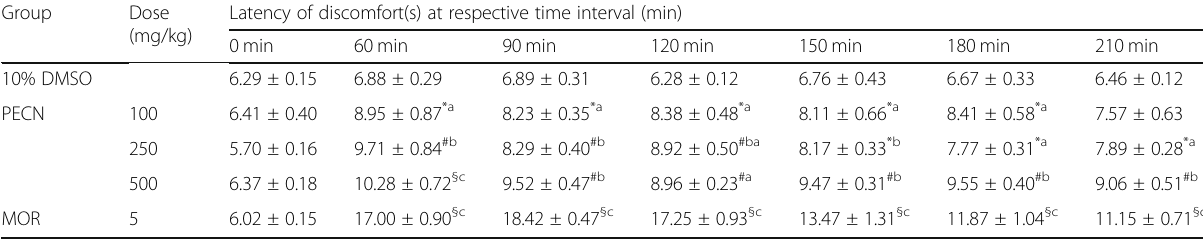
Data expressed are the mean±SEM of reaction time (sec) of six mice Statistical analysis was performed using two – way ANOVA followed by the Bonferroni post hoc test